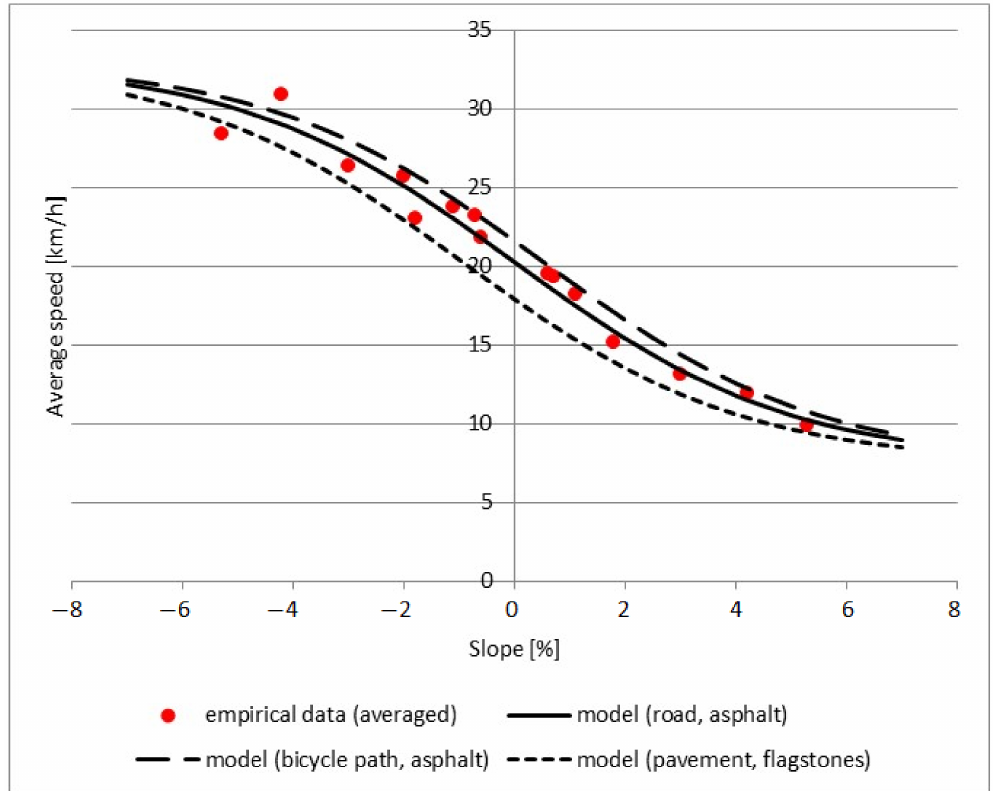
Figure 3. The relation between the average speed Vel i of cycling on the longitudinal slope and the characteristics of the